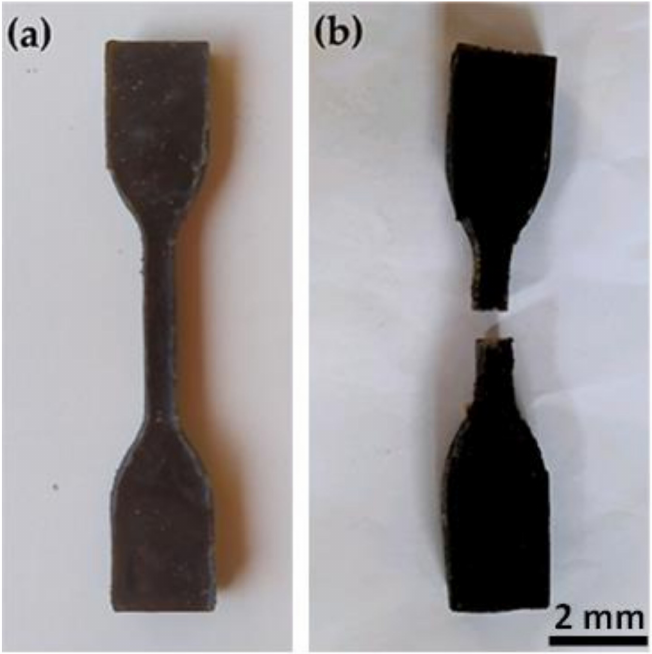
Figure 2. Standard specimen for the tensile test; ( a ) before test and ( b ) after test.